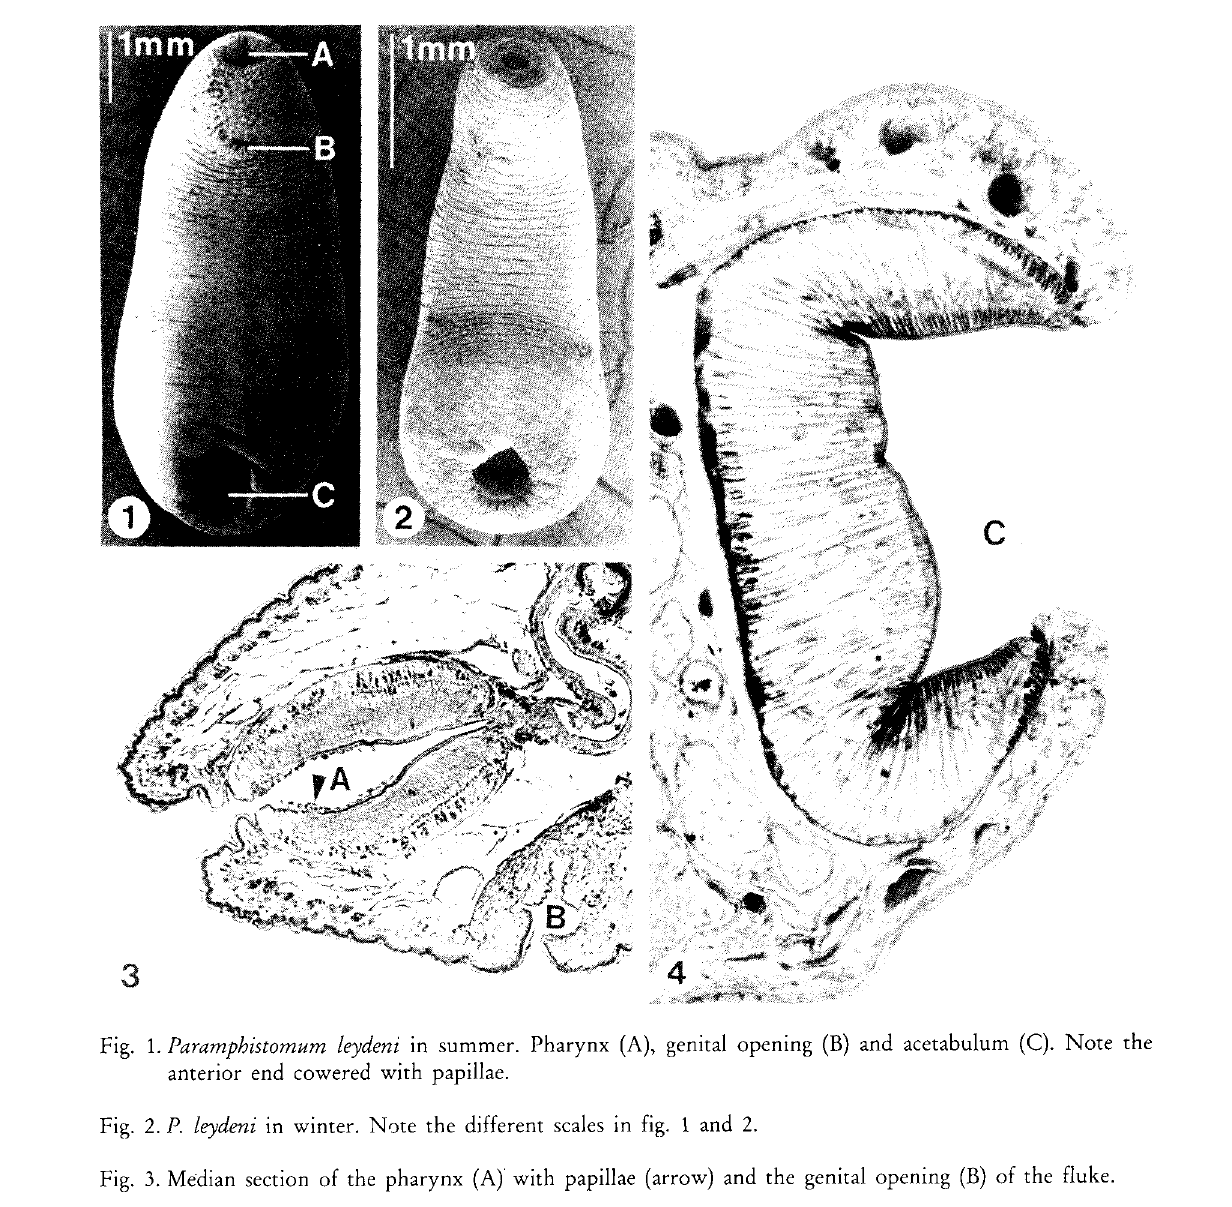
Fig. 1. Paramphistomum leydeni in summer. Pharynx (A), genital opening (B) and acetabulum (C). Note the anterior end cowered with papillae. Fig. 2. P. leydeni in winter. Note the different scales in fig. 1 and 2. Fig. 3. Median section of the pharynx (A) with papillae (arrow) and the genital opening (B) of the fluke. Fig. 4. Median section of the acetabulum